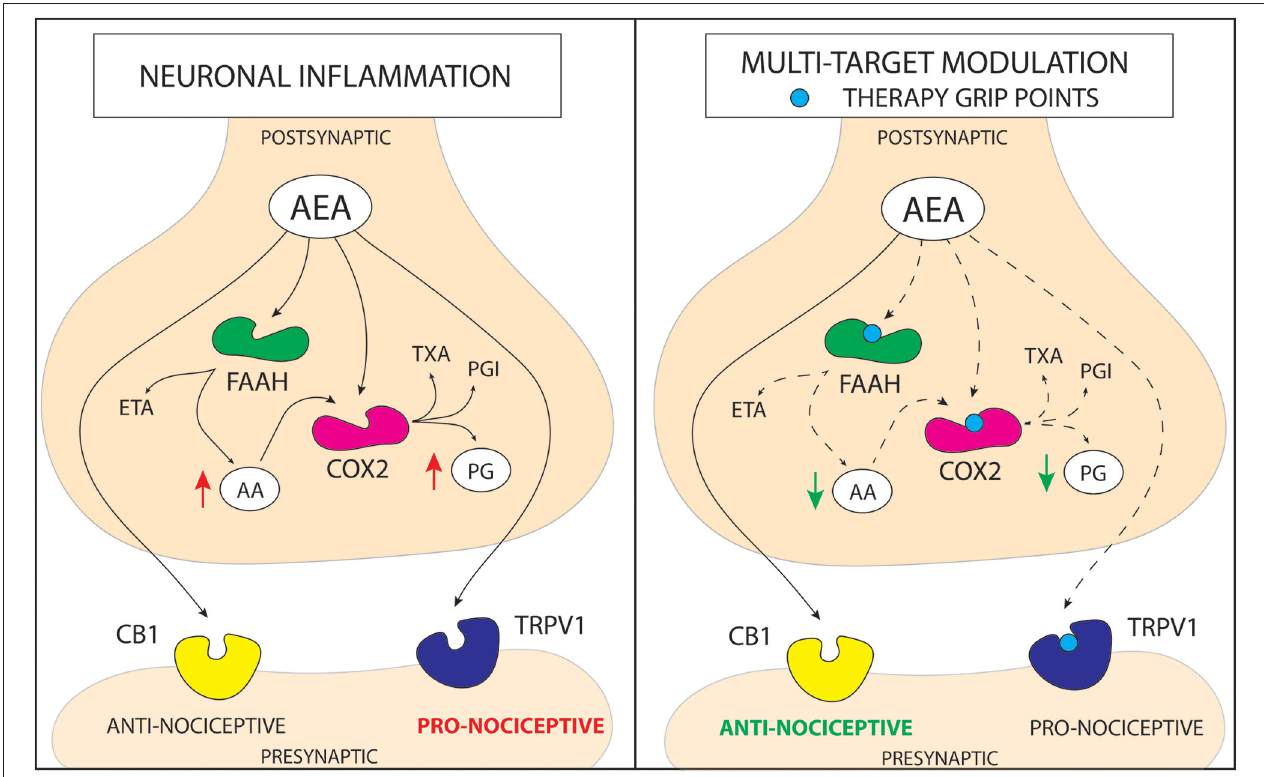
FIGURE 1 | Schematic representation of a mechanism of action for cannabinoid based multi-target drugs. The novel strategy for the pain treatment is based on altering more than one enzymatic reaction and/or nociceptive pathway. Anandamide (AEA) is hydrolyzed into arachidonic acid (AA) and ethanolamine (ETA) principally by fatty acid amide hydrolase (FAAH). In addition to its hydrolysis by FAAH, AEA is metabolized by COX-2. On the other hand, COX metabolizes AA, leading to increase in pro-inflammatory prostaglandins (PG). AEA can act on transient receptor potential cation channel subfamily V member 1 (TRPV1) activating pro-nociceptive pathways or through cannabinoid receptor 1/2 (CB1/2) pathway leading to alleviation of pain. Although, in the molecular stress conditions elevation of AEA occurs, FAAH and COX quickly metabolize it. Therefore, there are three pathways that may increase anti-nociceptive properties of AEA; (1) inhibition of FAAH enzyme, that leads to an increase in AEA level and a decrease in AA level; (2) inhibition of COX enzyme, that leads to an increase in AEA level and a decrease in PG level; (3) antagonism of TRPV1 receptor, which prevents activation of pro-nociceptive pathway by AEA. Action on more than one molecular target lowers the redundancy of the system and may lead to obtaining more stable and robust response in pain alleviation. (PGI—prostacyclins;